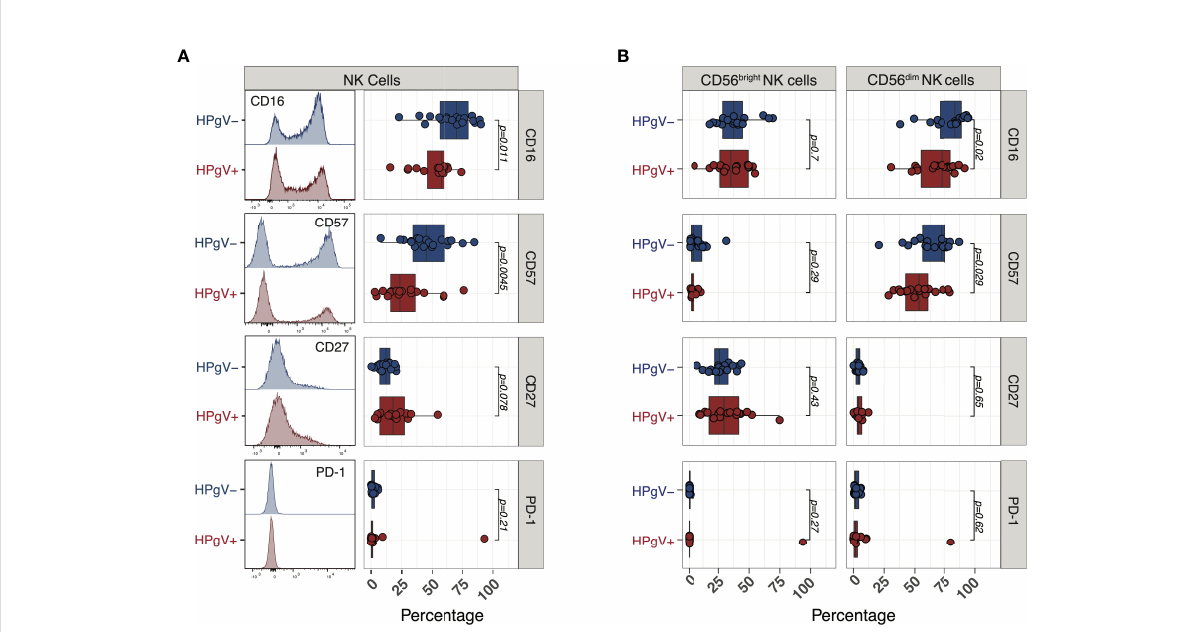
FIGURE 5 Expression of NK cell differentiation markers in HPgV-1-viremic and non-viremic HSCT recipients. (A) Representative FACS histograms (left panels) and summary of percentages (right panels) of expression of the indicated markers in NK cells recovered at 6 months post-HSCT from HPgV-1-viremic (HPgV+; red fi lled symbols) and HPgV-1-non viremic (HPgV-; blue fi lled symbols) HSCT recipients. (B) Summary of percentages of expression of the indicated markers in CD56bright (left panels) and CD56dim (right panels) NK cells recovered at 6 months post-HSCT from HPgV-1-viremic (HPgV+; red fi lled symbols) and HPgV-1-non viremic (HPgV-; blue fi lled symbols) HSCT recipients. Results in the two patient groups were compared using a nonparametric Mann-Whitney U